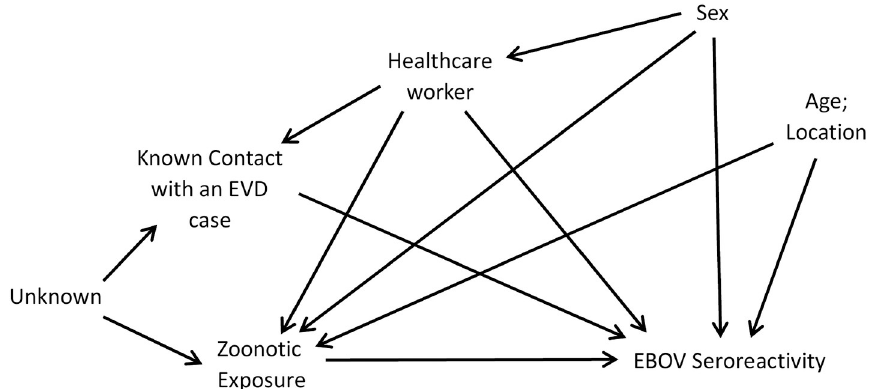
Fig 2. Directed Acyclic Graph (DAG) depicting hypothesized causal structure of zoonotic exposure and Ebola virus seroreactivity among individuals with no history of Ebola Virus Disease. Age and location are assumed to be simple confounders, influencing both presence of zoonotic exposures and Ebola virus (EBOV) seroreactivity. Sex is assumed to influence both zoonotic exposure and seroreactivity, and to be associated with healthcare worker status, as women were more likely to be healthcare workers in our sample. Being a healthcare worker is assumed to influence EBOV seroreactivity, due to potential for unknown exposures to Ebola Virus Disease (EVD) cases, and zoonotic exposure, due to relatively low contact with animals and forest when compared to non-healthcare workers. Working in healthcare is assumed to raise an individual’s risk of having known contact with an EVD case, which in turn is assumed to increase an individual’s risk of EBOV seroreactivity. Our DAG includes a residual confounding path through an unknown ancestor of zoonotic exposure and contact with an EVD case. In the analysis we controlled for contact with an EVD case as a proxy for this unknown confounder, which led to a more conservative